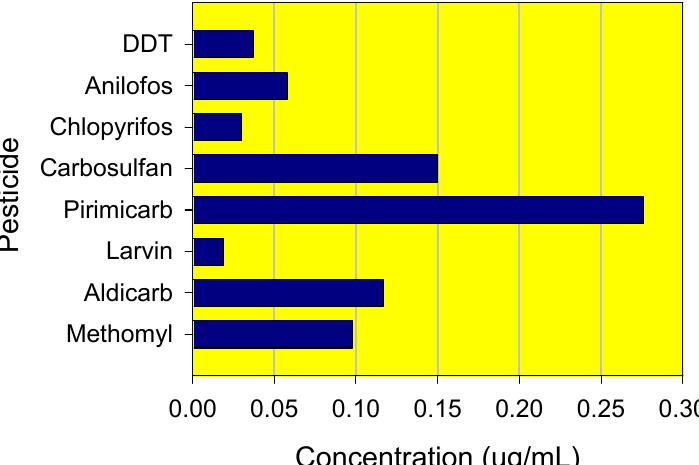
Figure 1. Maximum concentrations of pesticide residues detected in surface waters.